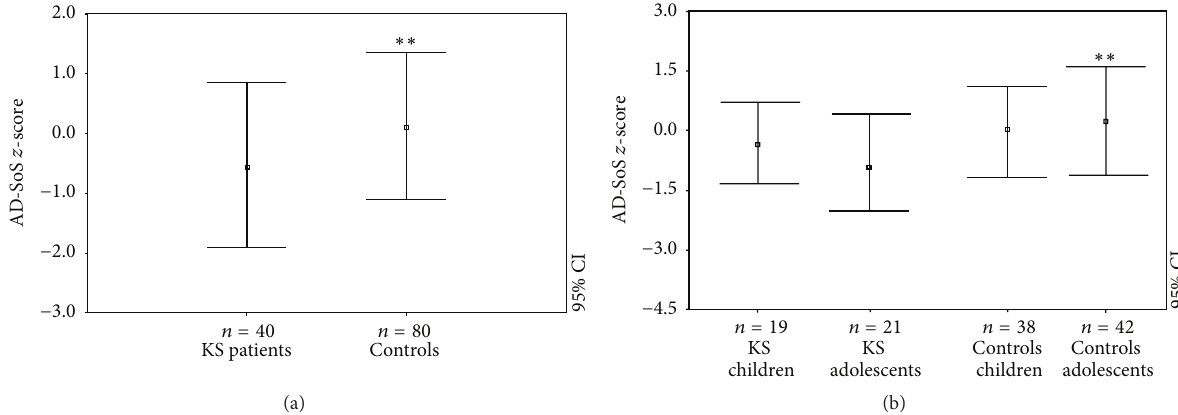
Figure 1: AD-SoS z -scores in KS patients and controls (a) and in KS patients and controls when classified by age group (as children and adults) with the relative control groups (b). ∗∗ 𝑝 < 0.005 .